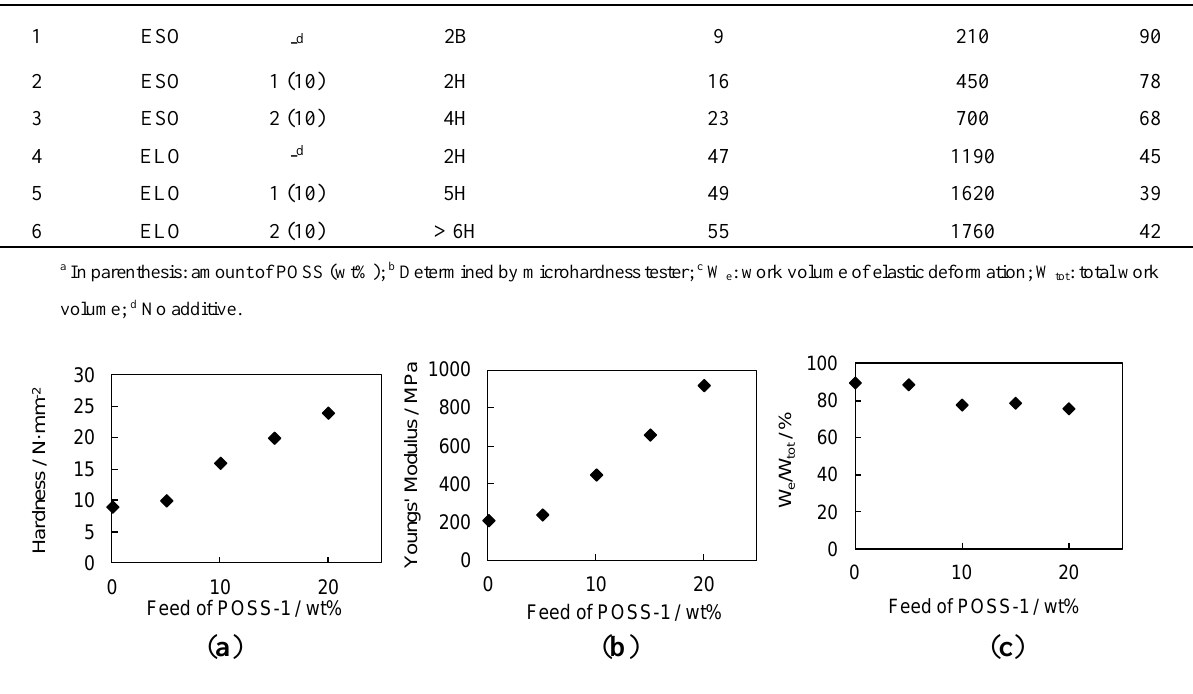
Figure 4. Relationships between feed ratio of POSS-1 and film properties of ESO/POSS-1 nanocomposite; ( a ) hardness; ( b ) Young’s modulus; and ( c ) W e /W tot